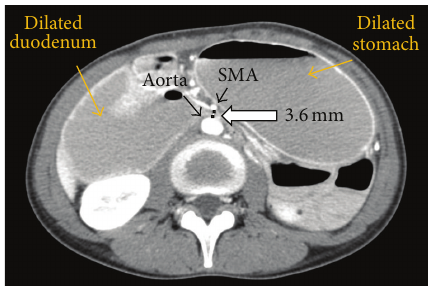
Figure 2: Contrast CT of the abdomen showing the distance between aorta and SMA (white arrow, marked as 3.6 mm). Also seen areadilatedstomachandduodenumandlocationoftheSMA(black arrow).